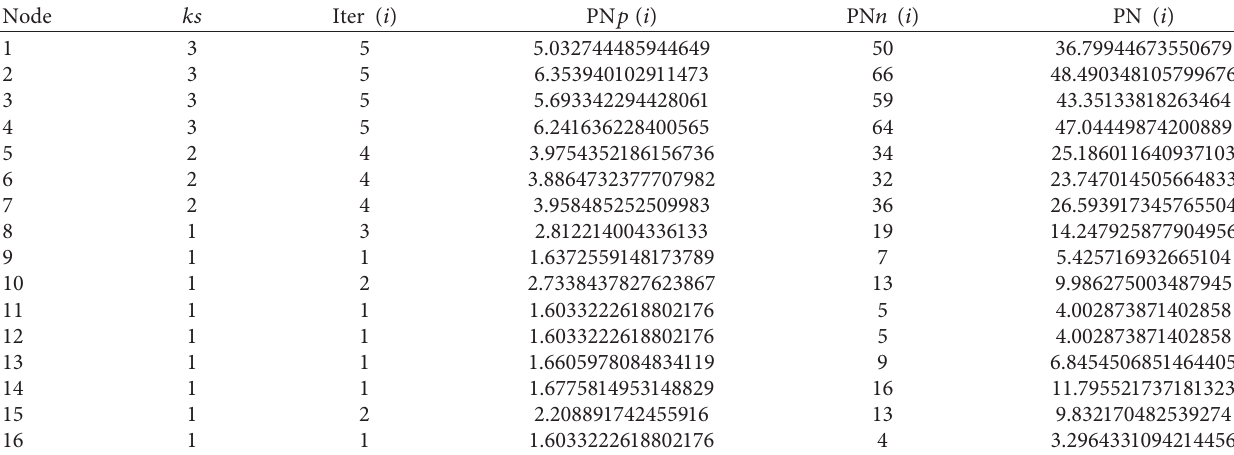
Table 1: Example verification results of K-shell-improved algorithm based on multiple or inner core nodes. Node ks